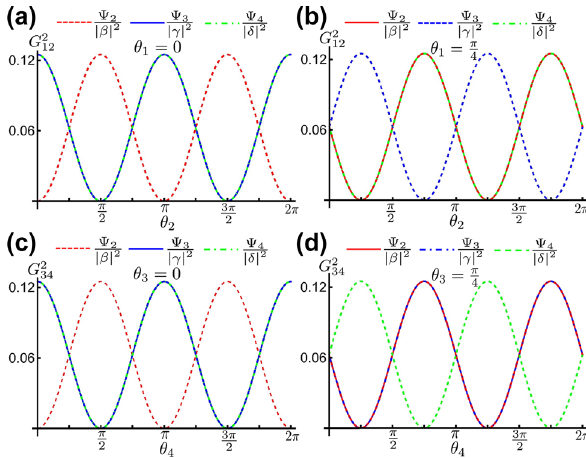
Figure 6: Coincidence counting outcomes for measurement of ⟩ , symmetric Bell states | Ψ ⟩ , | Ψ ⟩ . (a, b) asymmetric Bell states | Ψ 2 3 4 , the detection For coincidence counting measurements G (2) 12 = 0, shows anticorrelation with Ψ and Ψ as 𝜃 probability of Ψ 2 3 4 1 shows anticorrelation with Ψ while the detection probability of Ψ 3 2 = 𝜋 ∕ 4. (c, d) For coincidence counting measurements and Ψ as 𝜃 3 1 , the probability of Ψ is anticorrelated with that of Ψ and Ψ as G (2) 2 3 2 34 𝜃 = 0, while the detection probability of Ψ is anticorrelated with 4 4 = 𝜋 ∕ and Ψ as 𝜃 that of Ψ 2 3 3